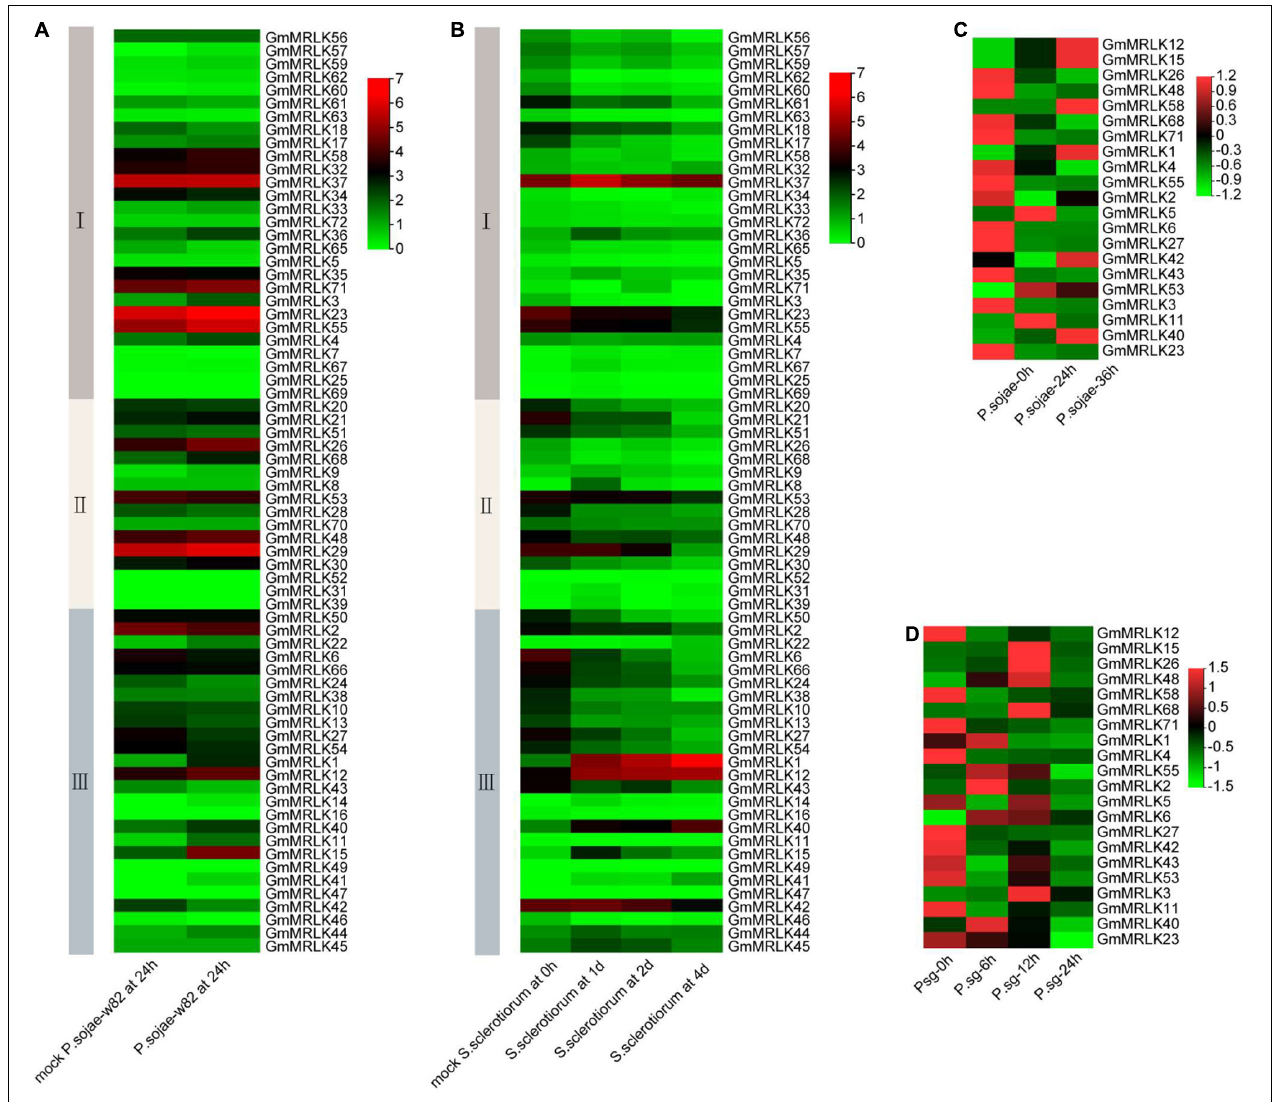
FIGURE 2 | Transcriptional expression of GmMRLK genes upon phytopathogens treatment. (A) Expression of GmMRLKs in response to P. sojae for 0 and 24 h. The analyzations were performed by Genevestigator database (https://www.genevestigator.com). The relative expression level of the GmMRLKs development stages were showed in the heatmap. (B) Expression of GmMRLKs in response to S. sclerotiorum at different infection stages. The analyzations were performed as in panel (A) . (C) Examination of GmMRLKs expression in responses to P. sojae by qPCR analysis. The hypocotyls of etiolated soybean seedlings at 4-days-old were treated with P. sojae 0, 24, and 36 h, total RNA was extracted and expression of the indicated GmMRLKs were analyzed by qPCR and showed by heatmap. (D) Examination of GmMRLKs expression in responses to Pseudomonas syringae pv. glycinea ( Psg ) by qPCR analysis. Soybean plants at 2-week-old were treated with P. sojae 0, 6, 12, and 24 h, total RNA was extracted and expression of the indicated GmMRLKs were analyzed by qPCR and showed by